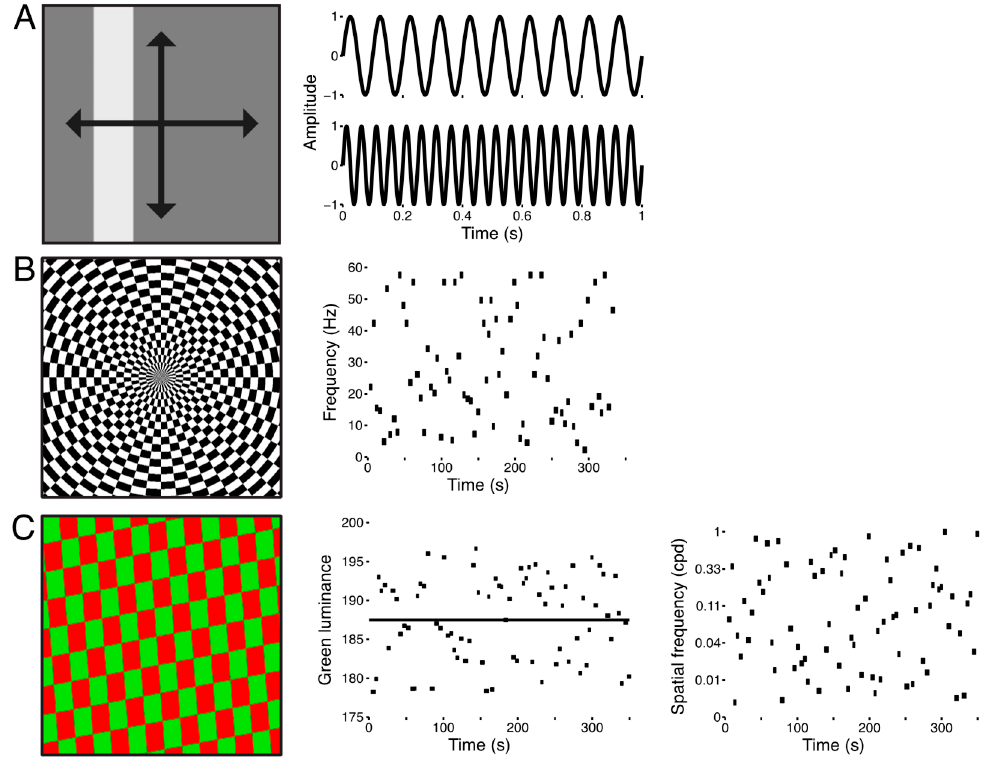
Figure 1. Stimuli used for the three experiments. ( A ) Sweeping bar stimulus. The spatially uniform flickering bar swept across the display 8 times in 4 directions and at 2 flicker frequencies, 10 Hz and 20 Hz. ( B ) Full-field flicker frequency stimulus. The stimulus was a checkerboard that subtended the entire display (left panel). The luminance of each checkerboard element was sinusoidally modulated between black and white. Flicker frequencies were drawn from a uniform distribution from 2–60 Hz and were presented for variable durations of 4–6 s. Each scanning run was comprised of 75 of these trials (right panel). ( C ) Full-field red-green isoluminance stimulus. The stimulus was a full-field checkerboard whose elements were colored red and green (left panel) and which reversed contrast at 15 Hz. We varied the luminance of the green elements ( ± 5%) about the predefined isoluminant reference point (middle panel, black line). We also varied the spatial frequency (right panel) and orientation (not shown) of the checkerboard pattern from trial to trial. Each functional run contained 75 of these trials, and the stimulus was repeated across all scanning runs so that a mean functional run could be computed.